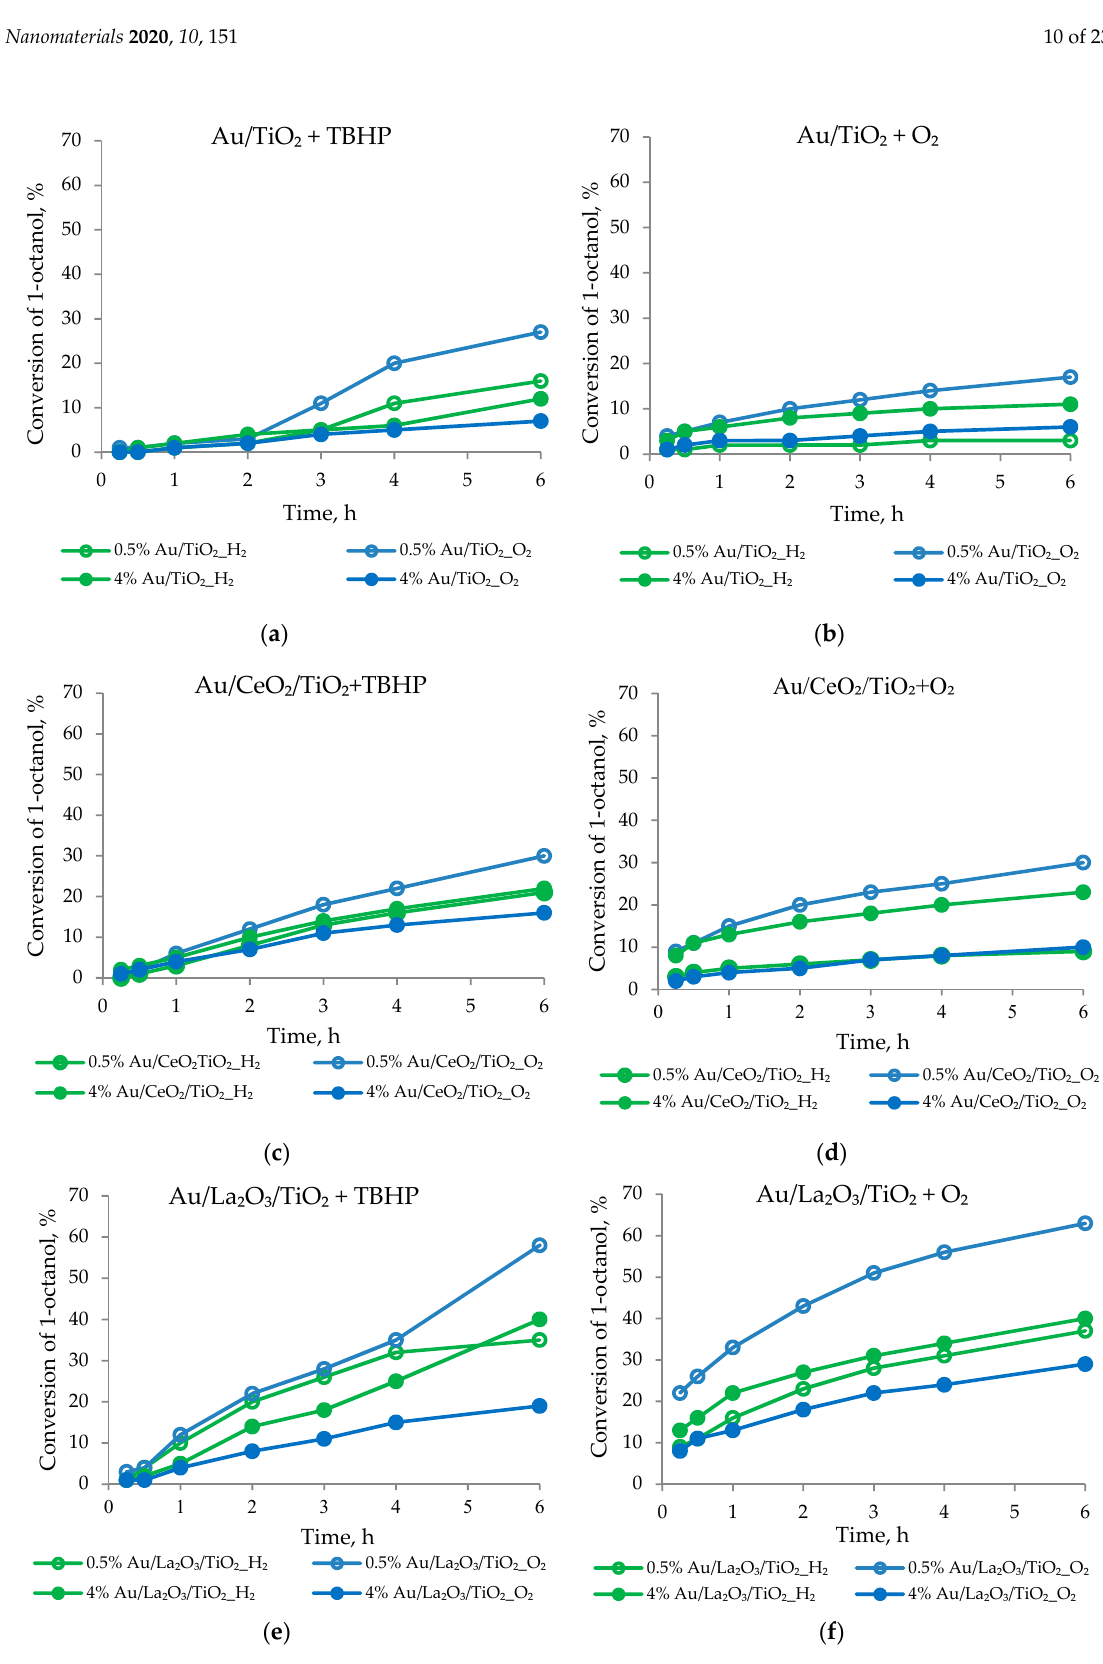
Figure 1. Time evolution of catalytic peroxidative ( a , c , e ) and aerobic ( b , d , f ) oxidation of 1-octanol. Reaction conditions of solvent-free peroxidative oxidation: R = 5000, TBHP: 1-octanol = 2.43; T = 80 °C, stirring = 800 rpm. Reaction conditions of aerobic oxidation: R = 100, 0.1 M 1-octanol in n-heptane; T = 80 °C, 30 mL/min O 2 , stirring = 800 rpm.